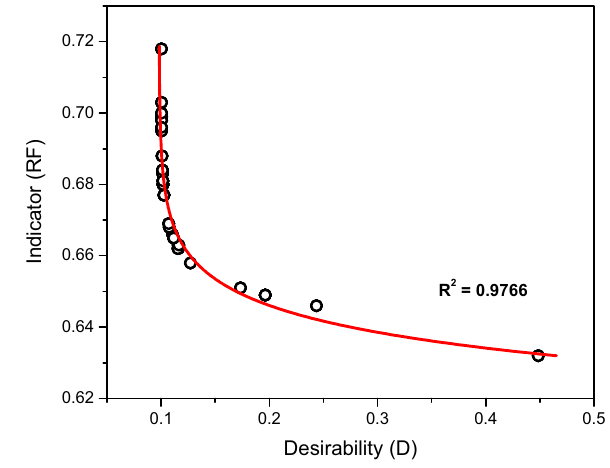
Fig. 6 Desirability ( D ) combined from three affecting factors to the recovery factor (RF) as an assessing indicator. The line is exponential curve